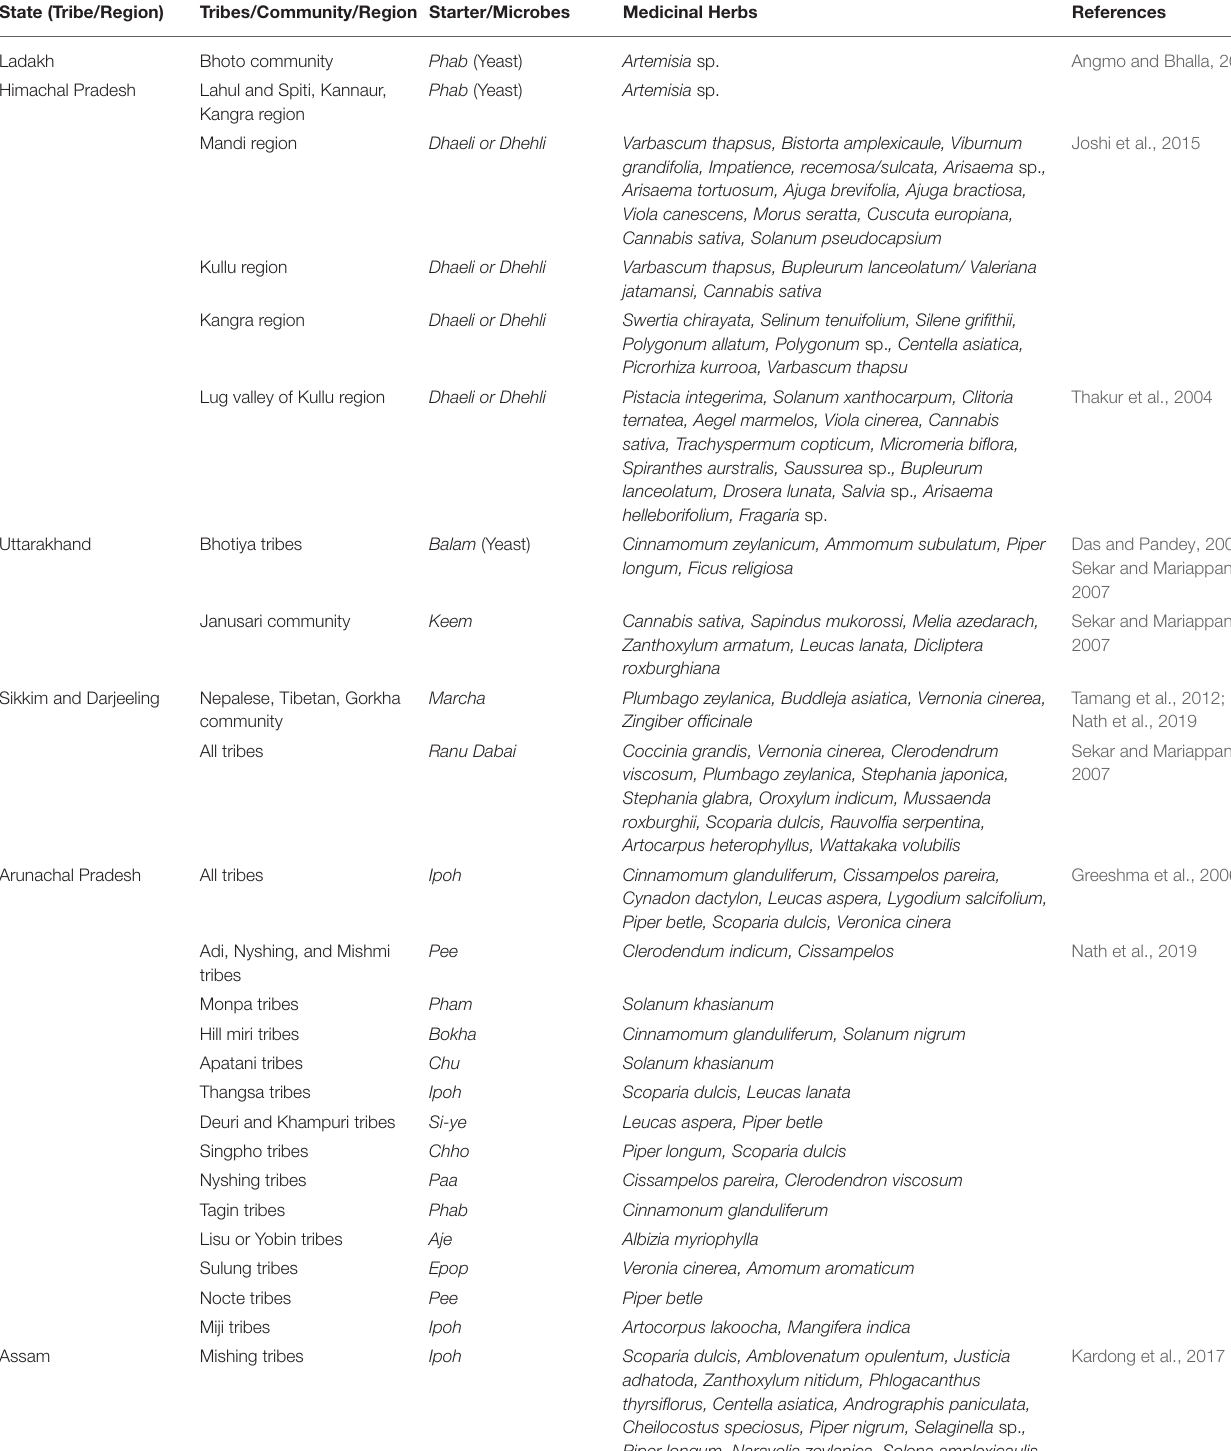
TABLE 2 | List of plant species used to prepare some popular starter cultures in the Indian Himalayan Region. State